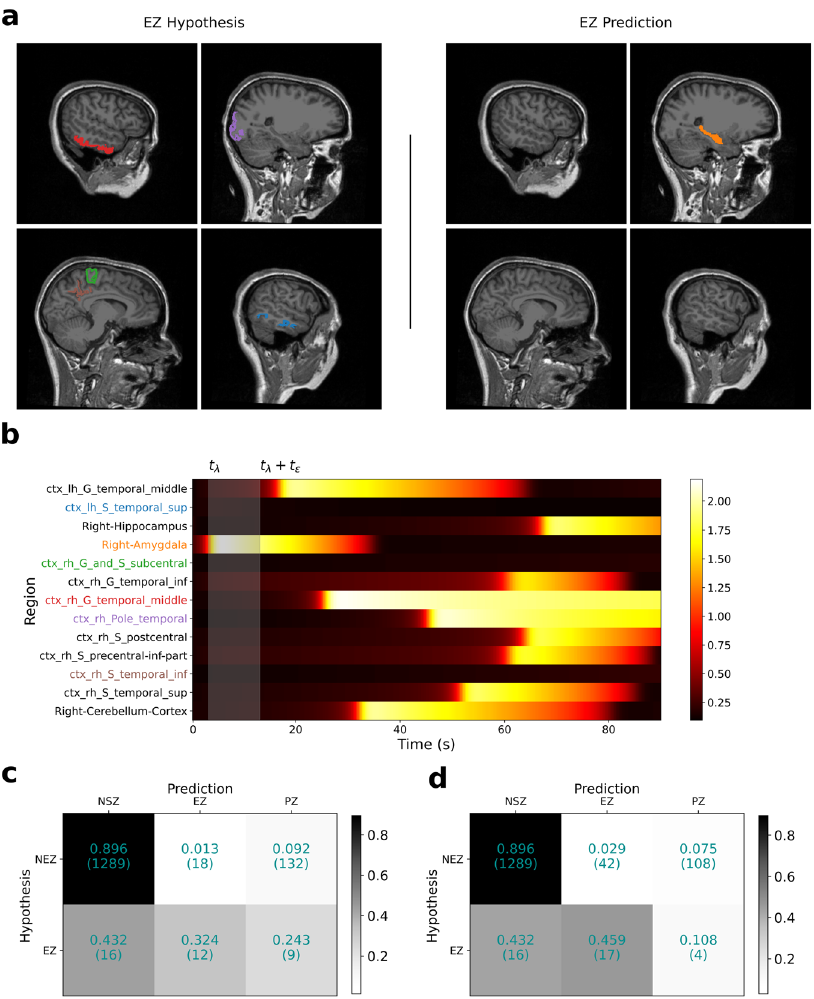
Fig. 6 Inferred seizure propagation pattern in patient FC with Engel score IV. a Comparison of clinical EZ hypothesis (left) with model-predicted EZ (right). b Model-predicted seizure propagation pattern as observed in the predicted source power. c Confusion matrix comparing clinical classi fi cation of brain regions and model prediction-based classi fi cation across all patients in the Engel score III/IV group at onset tolerance ( t ϵ ) of 10 s. d Same as in ( c ), except t ϵ = 30 s. Fitting between model predictions and observed data features is shown in Supplementary Fig. 4. Ez, epileptogenic zone.